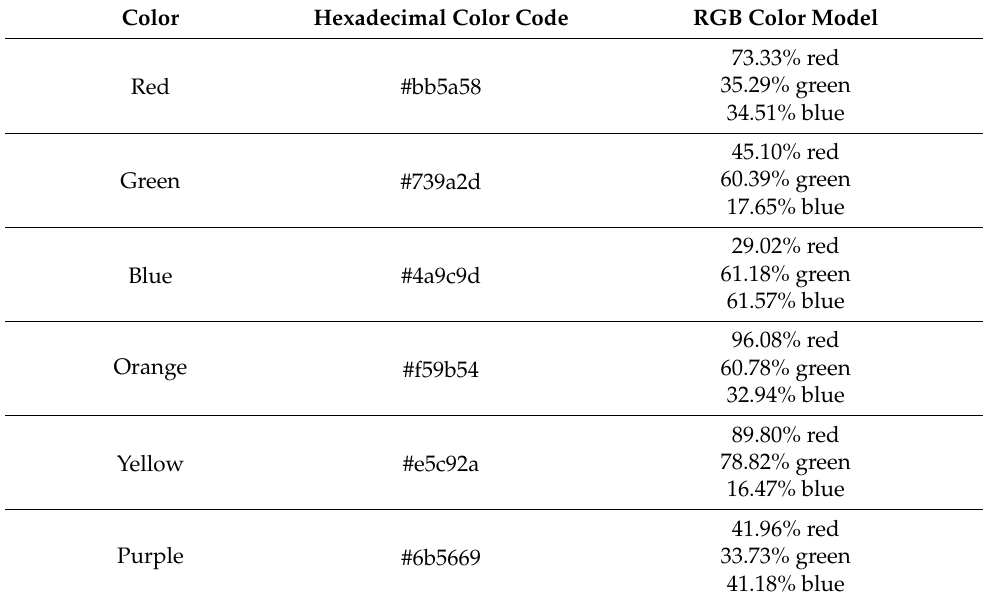
Table 1. Color Specifications for Each Diet Treated with a Non-Nutritive Food-Grade Dye (Trials 1 and 2).